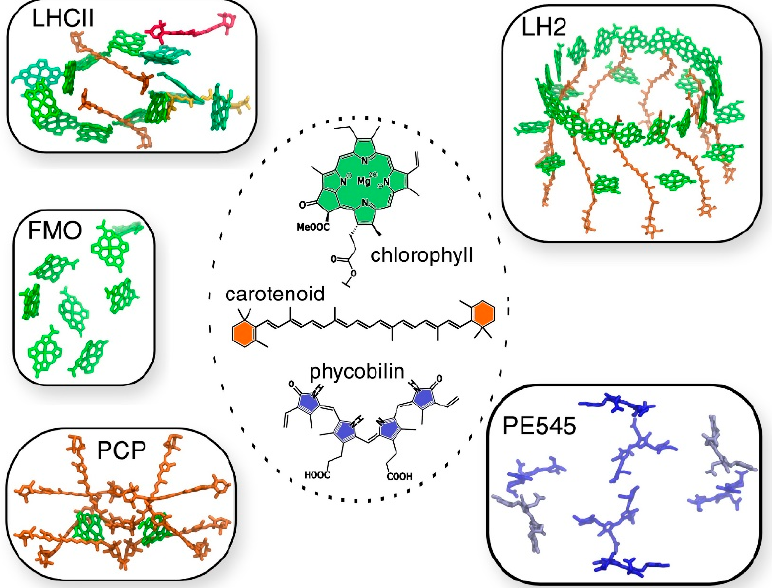
Figure 5. Examples of multichromophoric aggregates as found in different LH complexes. Starting from the left upper corner we see the major LH complex of plants LHCII (here represented in its monomeric form), the LH2 from Rhodoblastus acidophilus (purple non-sulfur bacteria), the phycoerythrin 545 (PE545) antenna of Rhodomonas sp. (marine algae), the peridinin–chlorophyll a–protein (PCP) from Amphidinium carterae (oceanic plankton) and the Fenna–Matthews–Olson (FMO) complex of Prosthecochloris aestuarii (green sulfur bacteria). In the central ellipse a schematic representation of the different types of pigments is reported; namely (bacterio)chlorophylls, carotenoids and bilins. Reprinted with permission from [68]. Copyright (2020) Elsevier.